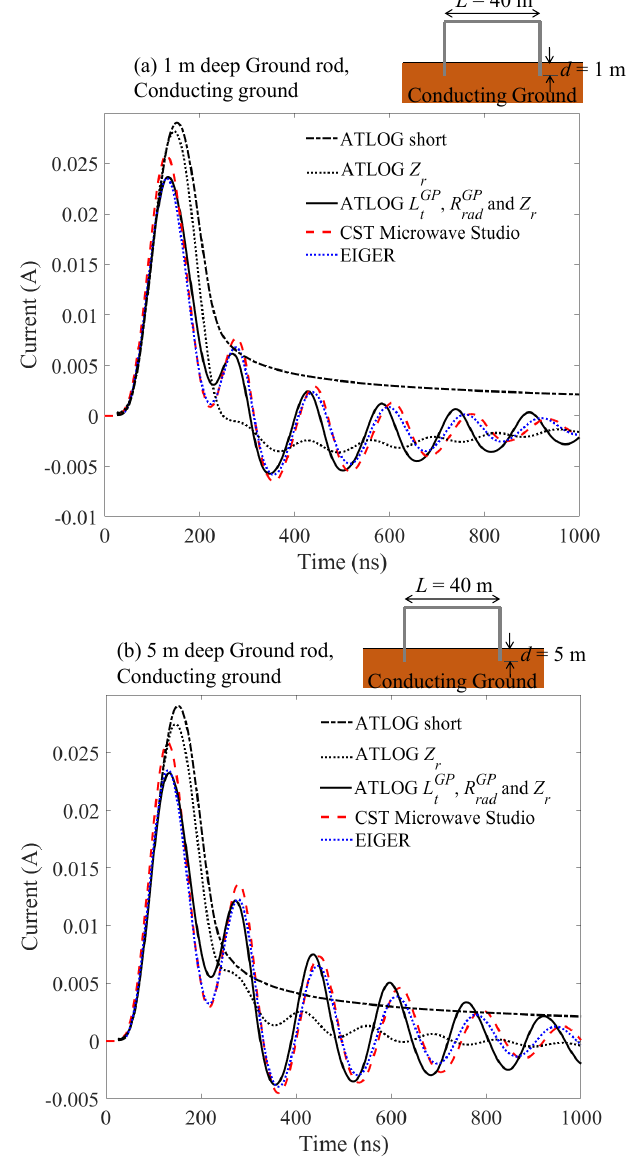
Figure 5: Comparison of full wave simulation using CST Microwave Studio (red dashed curve) and EIGER (blue dotted curve) with the ATLOG transmission line calculations for a 40 m long section of line over a conducting ground (with relative permittivity of 20 and conductivity of 0.01 S/m) having (a) 1 m deep and (b) 5 m deep ground rods at both ends. The dashed- dotted curve has idealized short circuits at each end, the black dotted curve has terminating rod impedances, and the solid curve has terminating inductors, rod impedance, and radiation resistances at each